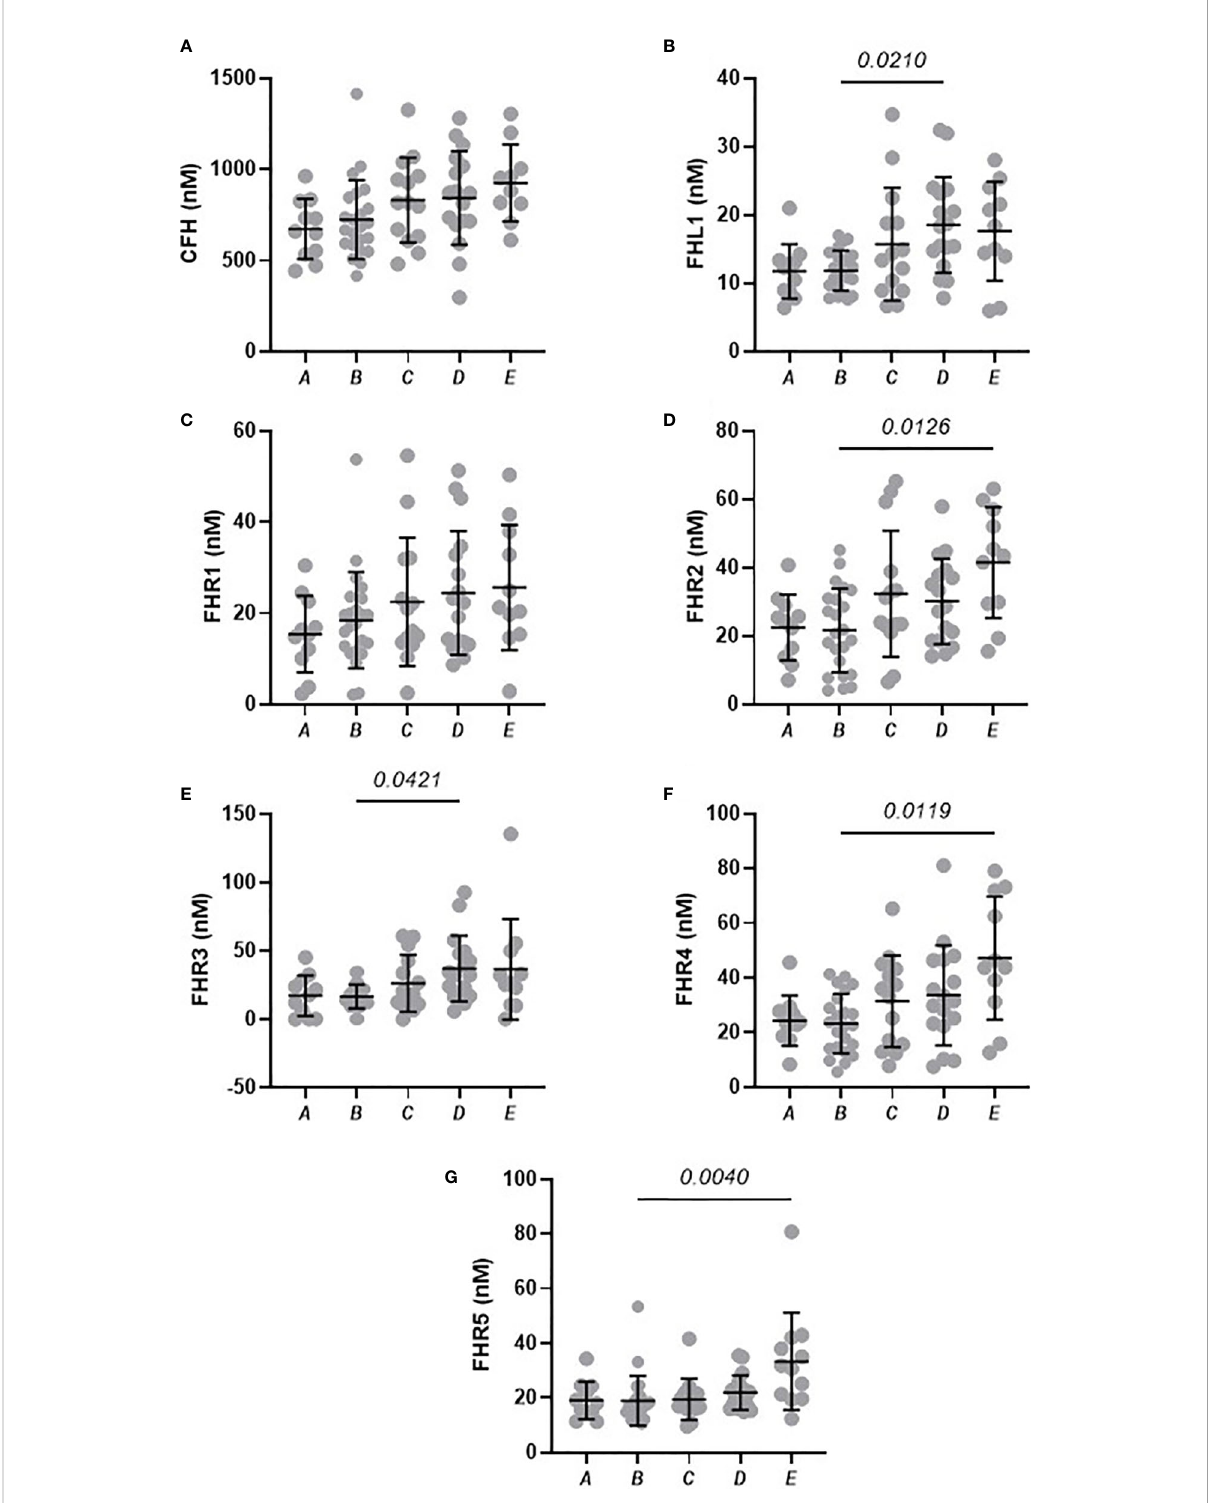
FIGURE 3 Circulatingconcentrationsof FHL-1andFHR1toFHR5inCOVID-19patientsafter28 days. Scatterplotsof FH (A) ,FHL1 (B) ,andFHR1toFHR5 (C – G) represent themeasuredplasmaprotein concentrationinnM.Pairwiseadjustedp-valueswereobtainedfromaTukey ’ smultiplecomparisonstest